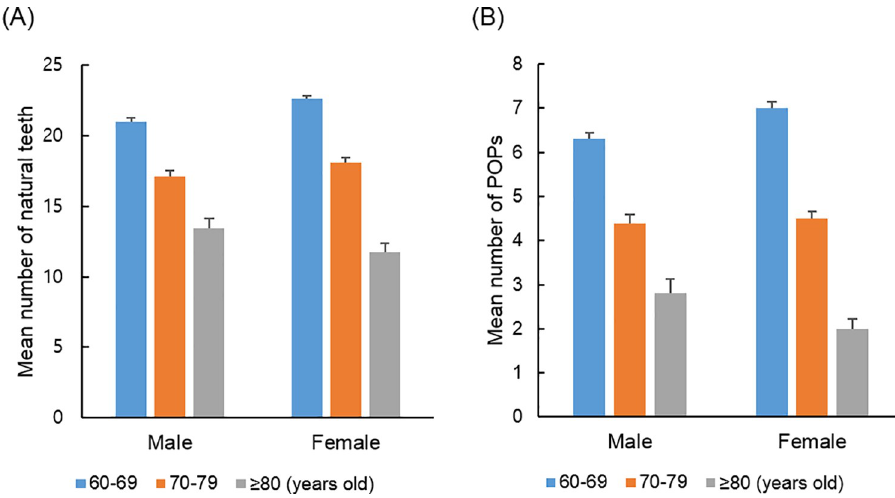
Fig 1. Decrease of the mean number of natural teeth and POPs with age. The number of (A) natural teeth and (B) POPs significantly decreased with age in both males and females ( P < 0.001). POPs, pairs of opposing posterior teeth.